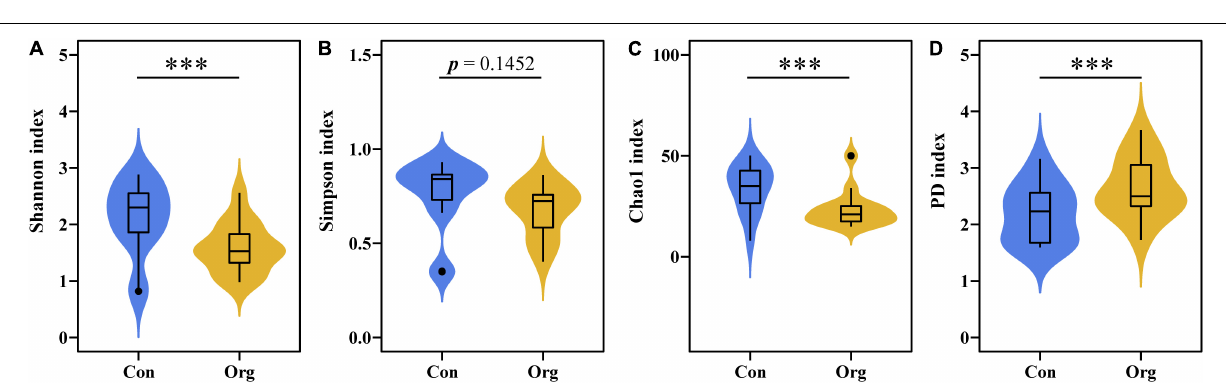
FIGURE 2 | The percentage of colonization (A) , colonization intensity (B) of roots, and soil spore density (C) on conventional (Con) and organic (Org) maize farms. The * represents the difference between two farming systems is significant at P = 0.05 level.